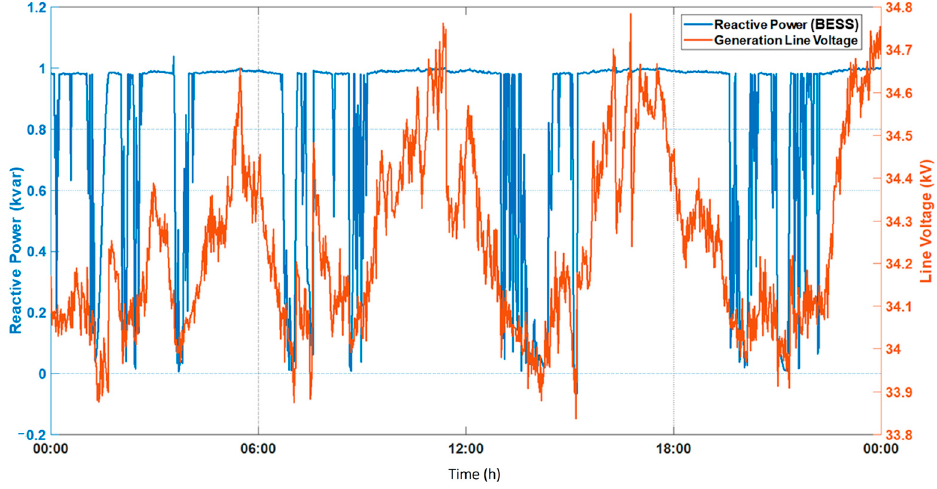
Figure 12. Voltage control performed by BESS. Measurement performed on 7 April 2021